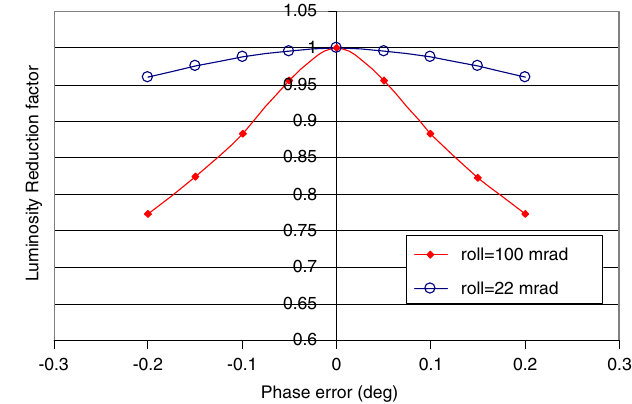
FIG. 7. (Color) The vertical offset against longitudinal position for the macroparticles in a bunch at the IP of the ILC where the crab cavity has a 10 mrad roll misalignment and there is an anticrab cavity correction.